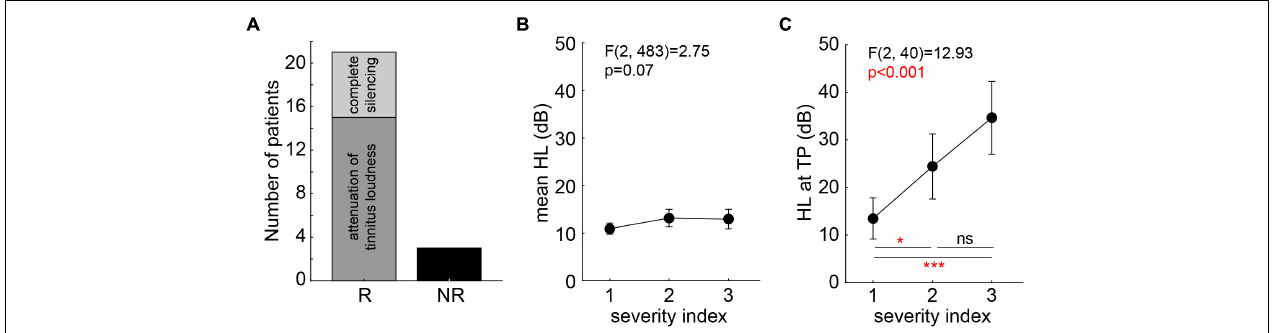
FIGURE 2 | Tinnitus patients’ categorization and severity indices. (A) Categorization of tinnitus patients according to their responses during stimulation (R, responder; NR, non-responder). R patients are separated for those with attenuation of tinnitus loudness only ( N = 15) and those with complete silencing ( N = 6). (B) One-factorial ANOVA of mean HL dependent on miniTQ12 severity index. (C) One-factorial ANOVA of HL at TP dependent on miniTQ12 severity index. Results of Tukey post hoc tests: ns not significant; * p < 0.05; *** p <